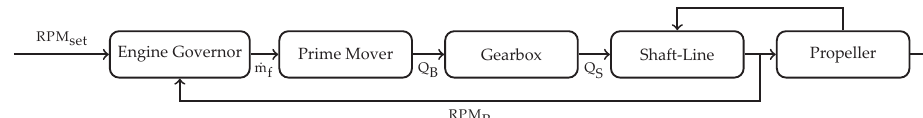
Figure 4. Layout of propulsion simulation